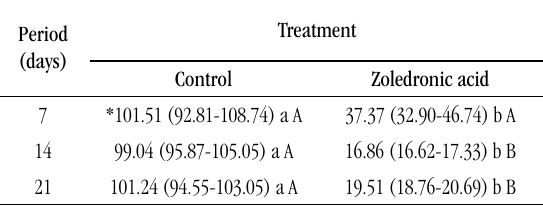
tABLE 1 – Alkaline phosphatase activity (%) of SaOs-2 cells, according to treatment and assessment